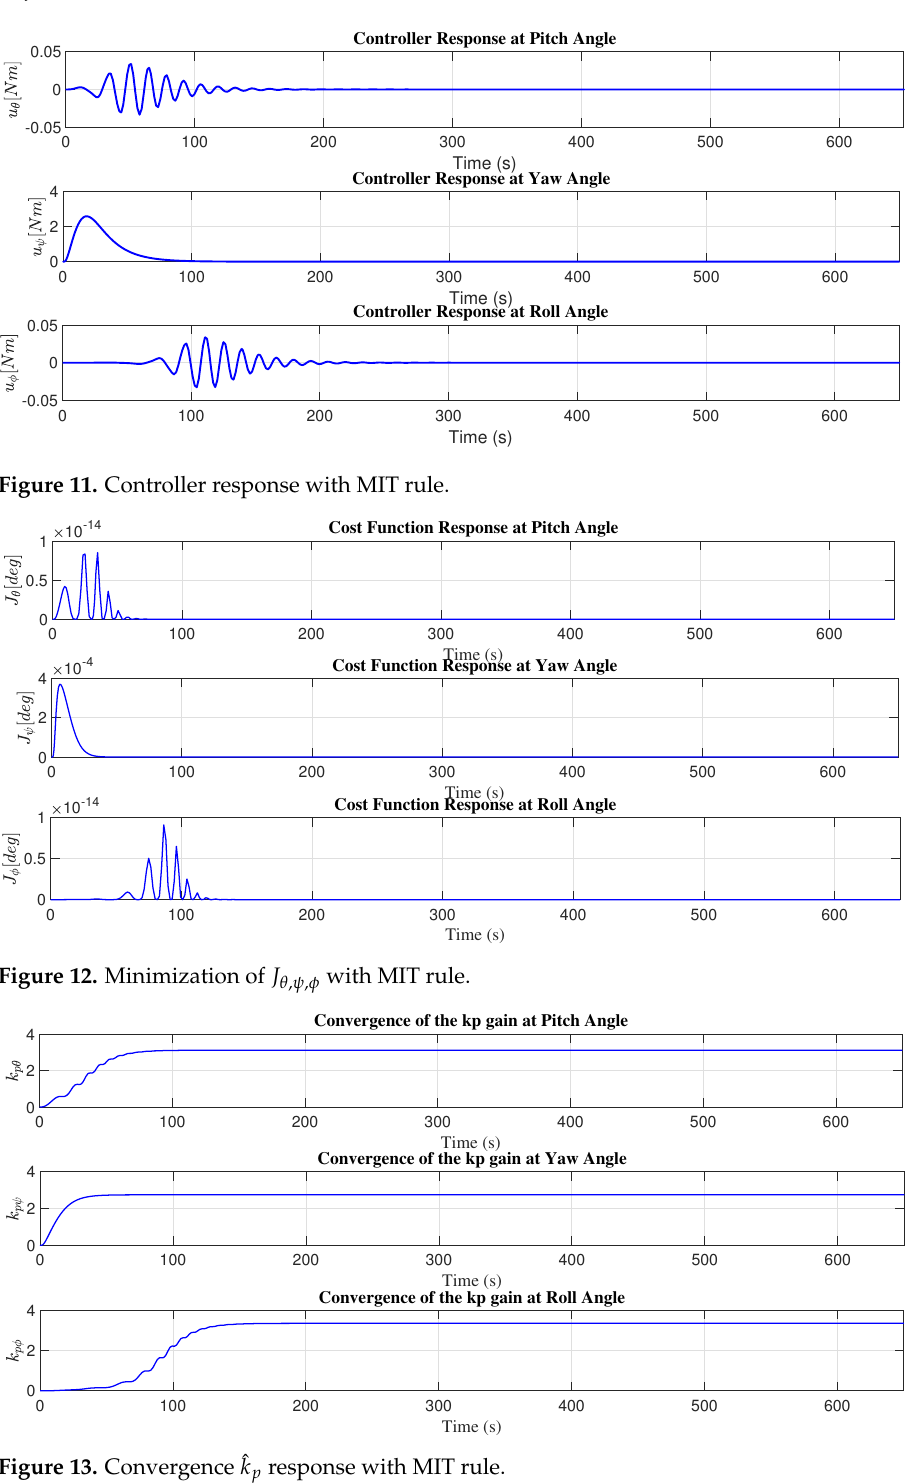
Figure 13. Convergence ˆ k p response with MIT